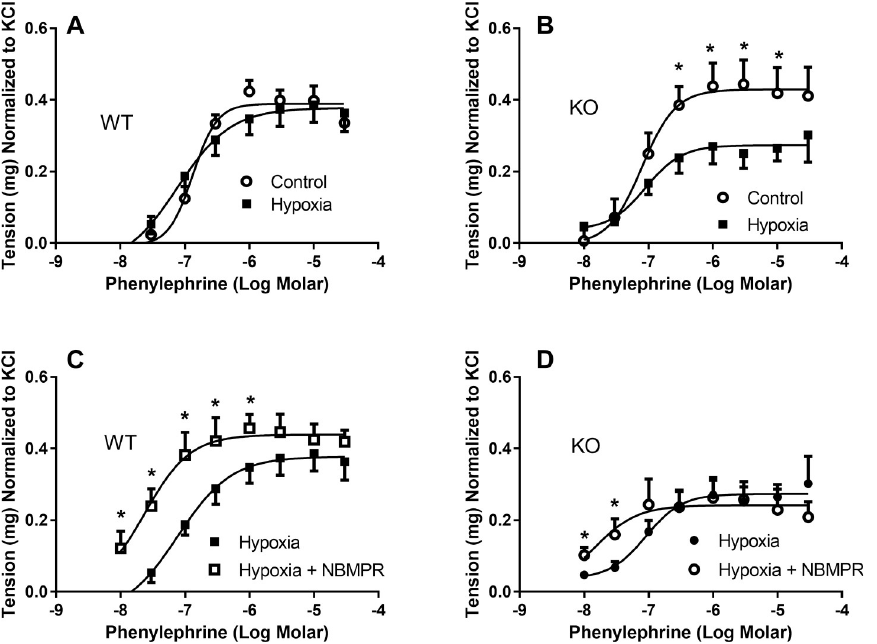
Fig 9. Phenylephrine dose-response curves for isolated thoracic aorta from wild-type (WT) and Slc29a1-null (KO) mice after exposure to hypoxia. Tissues were incubated for 30 min at 37˚C in KPSS buffer at resting tensions of 500 mg after which they were depolarized with 100 mM KCl. Tissues were then incubated for 60 min under either normoxic or hypoxic conditions, and then exposed to increasing concentrations of phenylephrine (Panels A and B). Panels C (WT) and D (KO) show the effect of 1 μ M NBMPR on the response to hypoxia. NBMPR was administered 15 min prior to hypoxia, and then removed prior to the construction of the phenylephrine dose-response relationship. Each point is the mean ± SEM from 6 (Panel A & B) or 5 (Panel C and D) experiments. � Significant difference between treatment groups (Student’s t-test for unpaired samples, � P < 0.05).